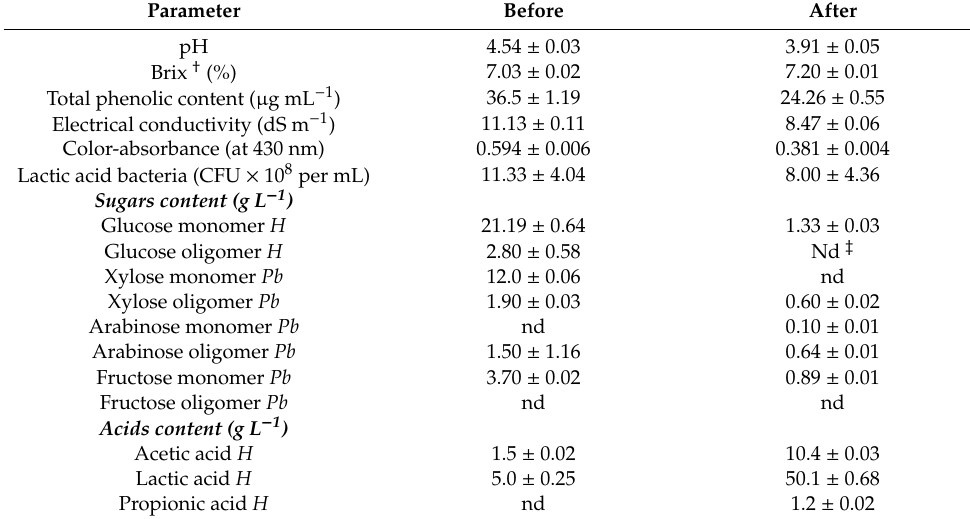
Table 1. Physiochemical characteristics of alfalfa brown juice before and after fermentation using